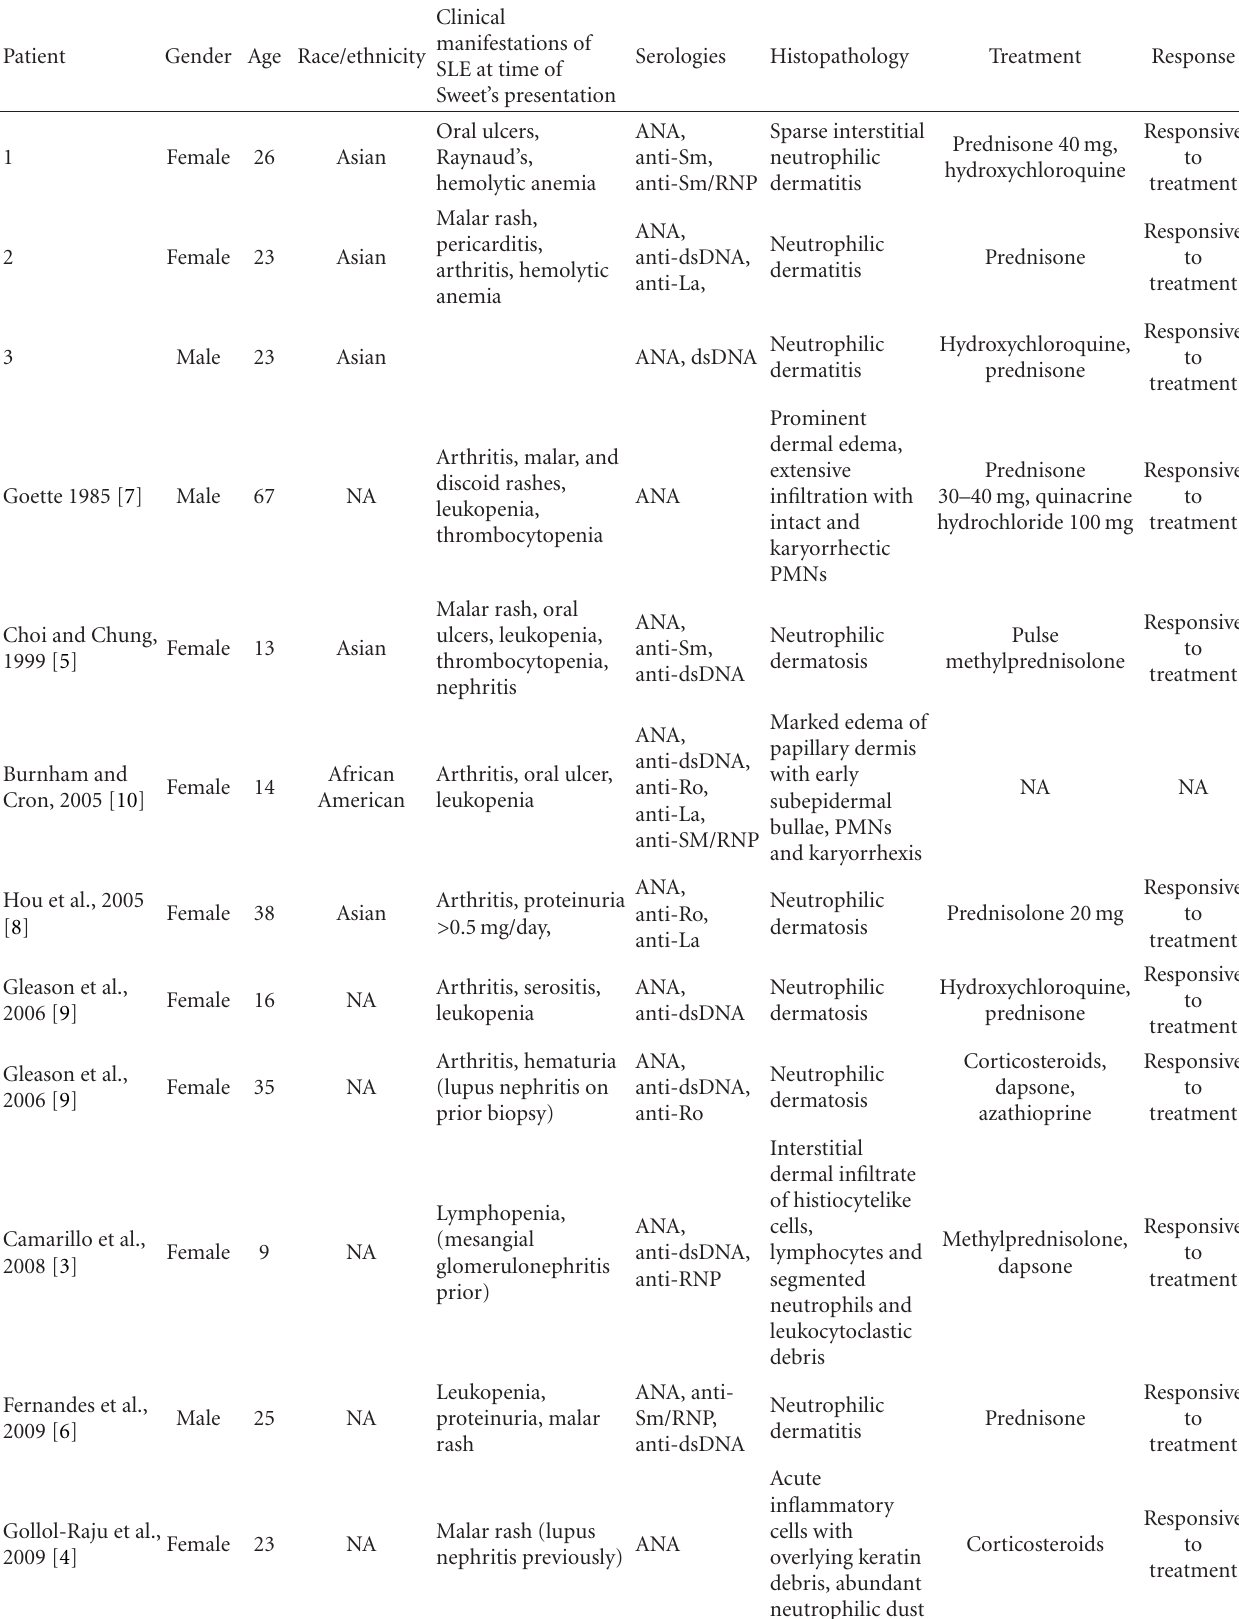
Table 1: Demographic and clinical characteristics of SLE patients at time of presentation with Sweet’s.